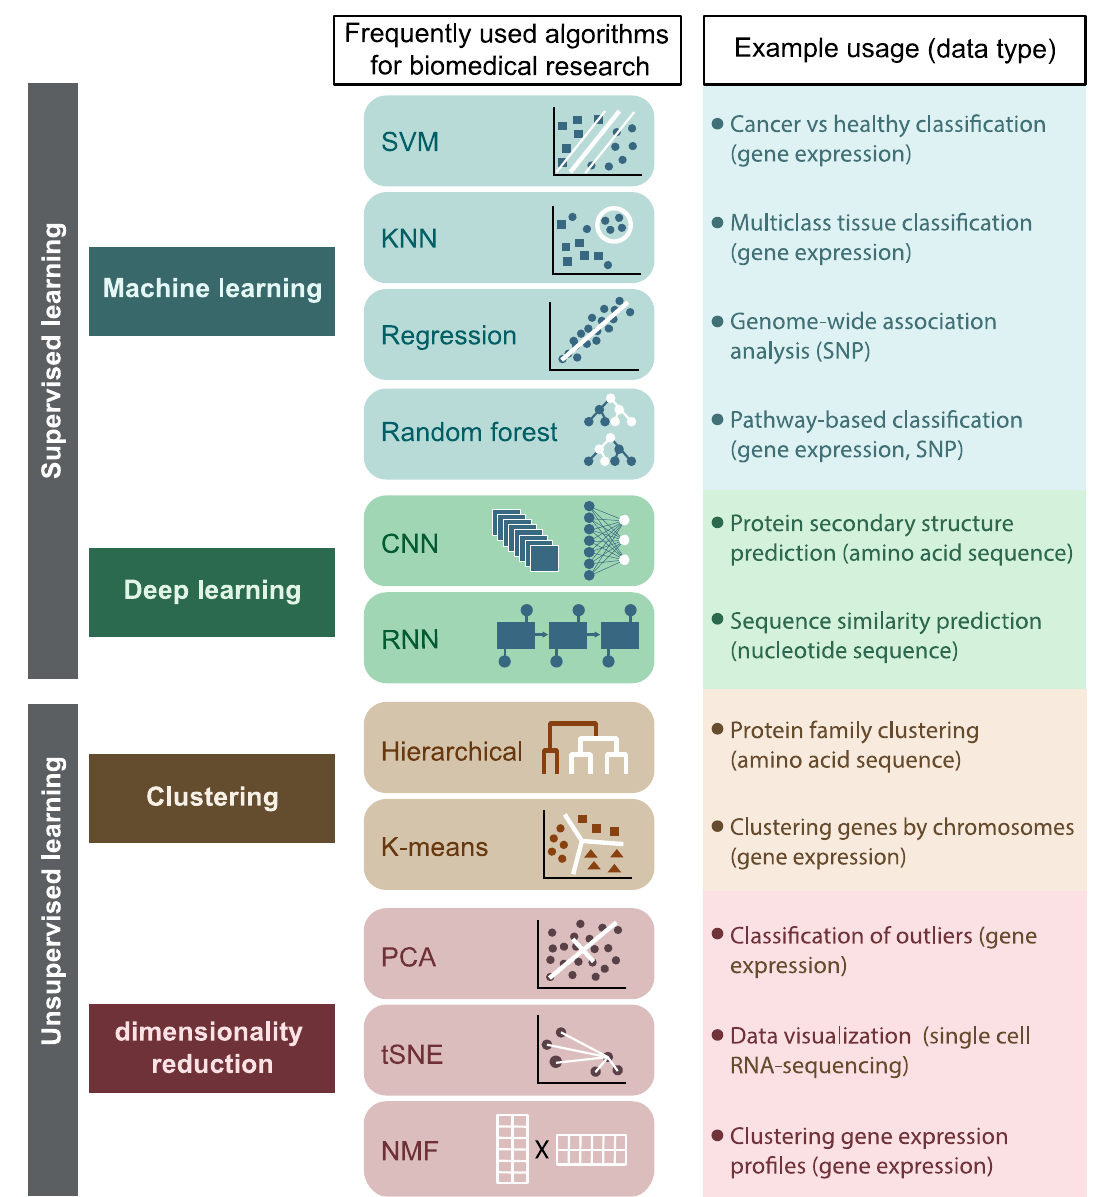
Figure 1. Machine learning algorithms frequently used in bioinformatics research. An example of the usage of each algorithm and the respective input data are indicated on the right. Abbreviations: SVM, support vector machines; KNN, K-nearest neighbors; CNN, convolutional neural networks; RNN, recurrent neural networks; PCA, principal component analysis; t-SNE, t-distributed stochastic neighbor embedding, NMF, non-negative matrix factorization.